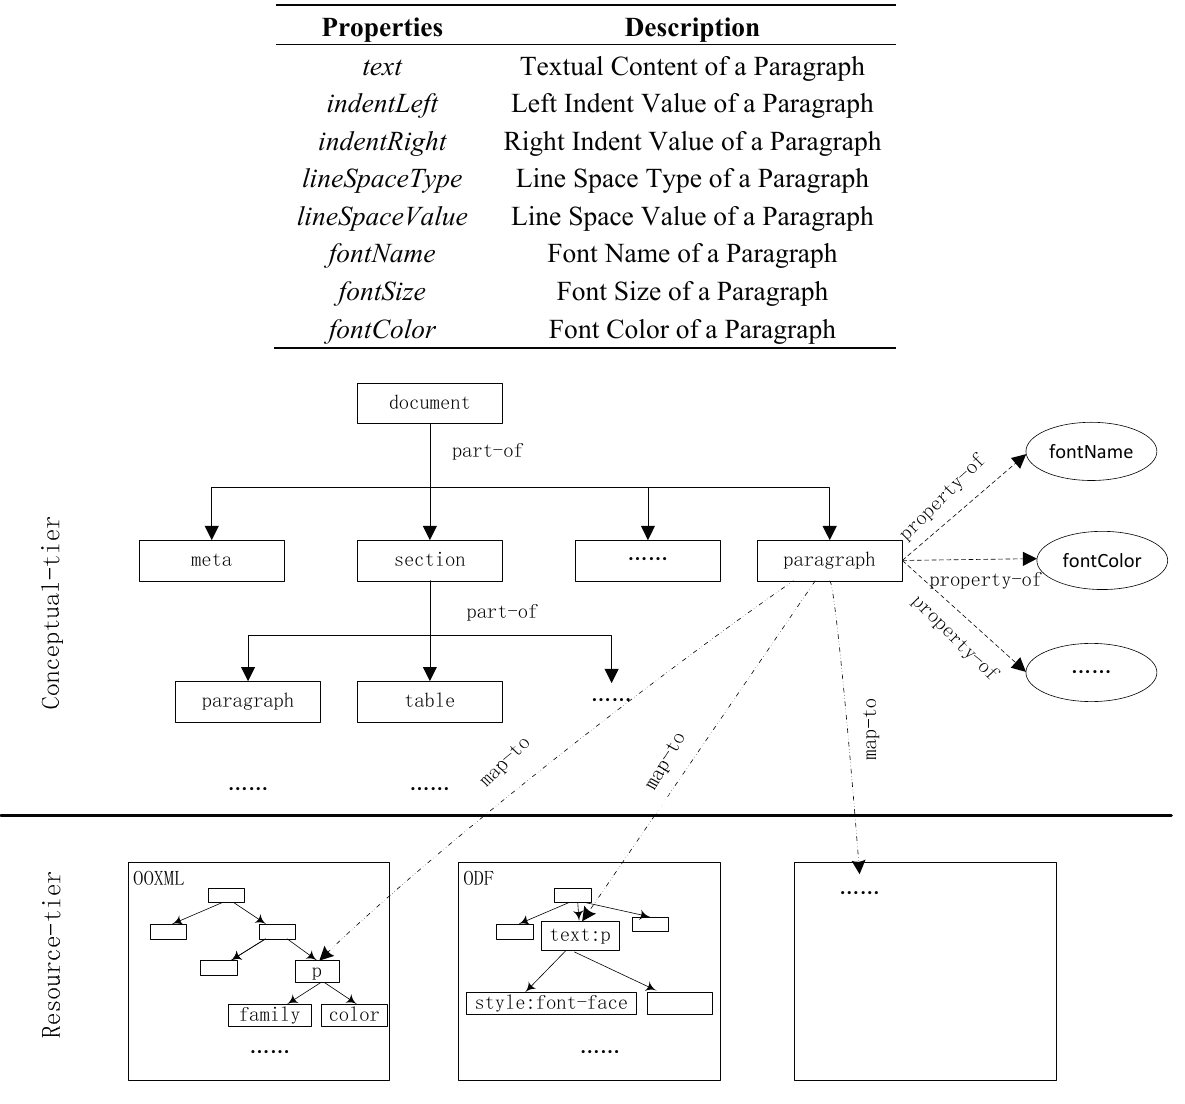
Figure 2. Common document model extraction